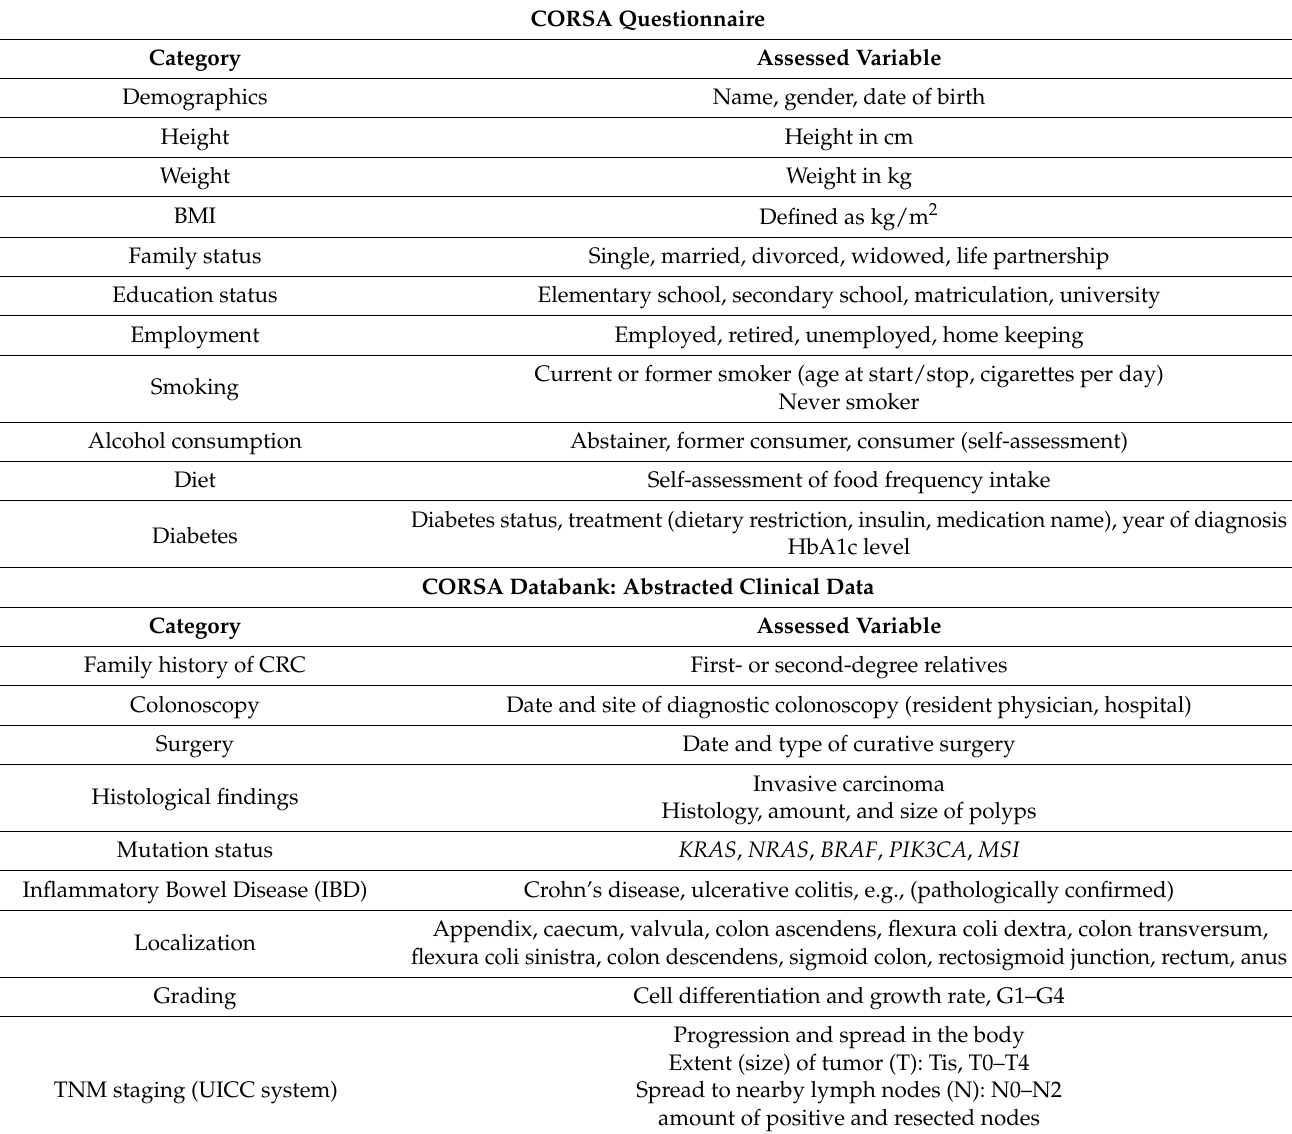
Table 2. CORSA data resources: questionnaire data and clinical